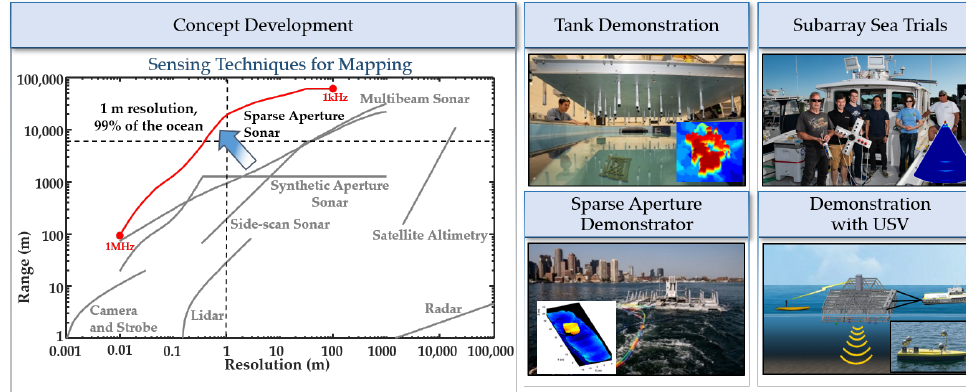
Figure 2. Progression from concept development to sea testing of the sparse aperture.